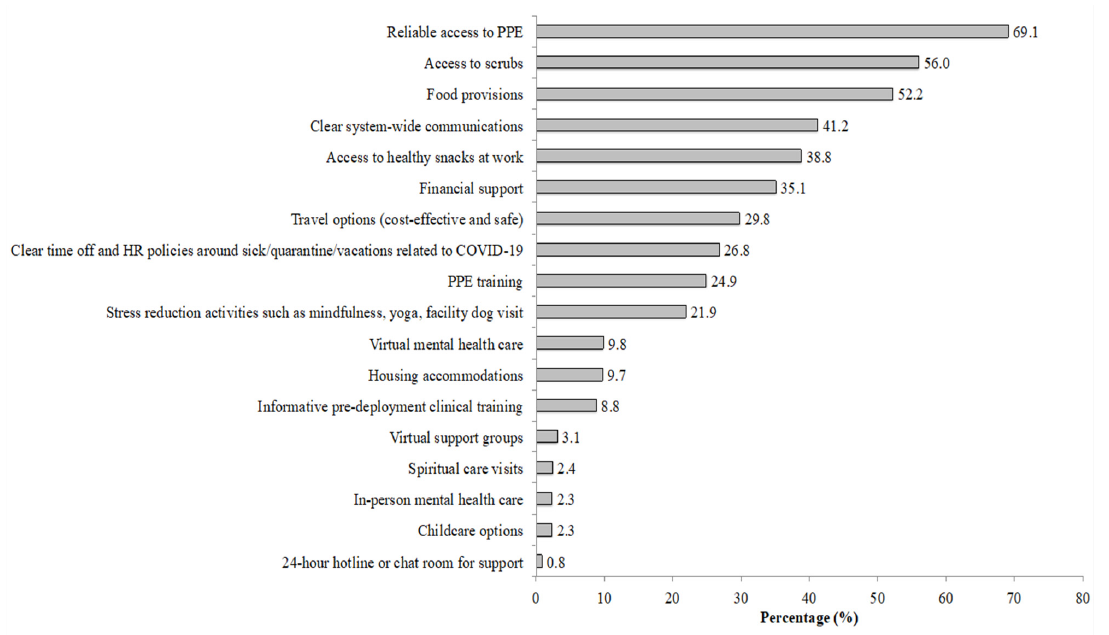
Figure 2. Support resources that COVID-19 frontline health care workers found helpful in